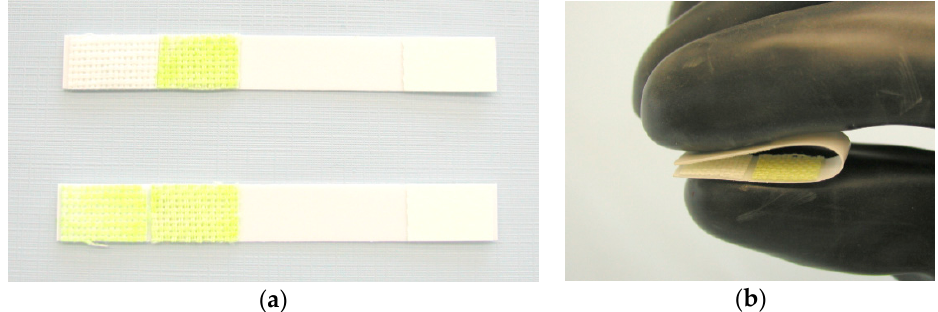
Figure 1. Biosensor Detehit: ( a ) appearance of the biosensor before and after use with a negative result; ( b ) the method of connecting the opposite zones after incubation.